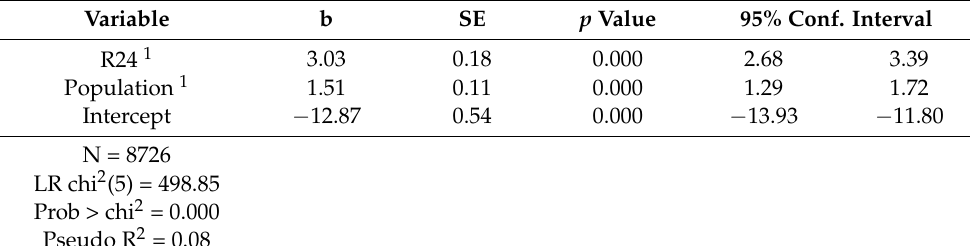
Table 1. Results for the logistic regression analysis of the probability of damage occurrence (DO) across the PCs of the AMA depending on R24 and controlled for the